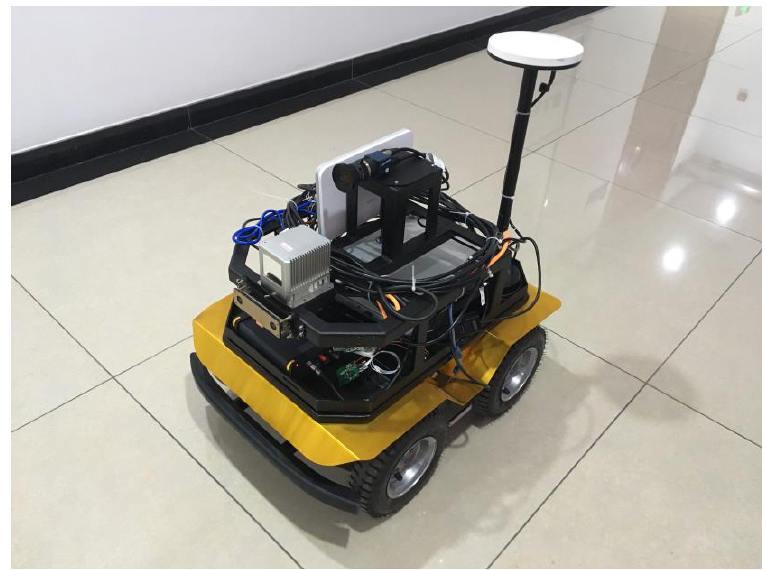
Figure 7. Experiment robot with sensors.